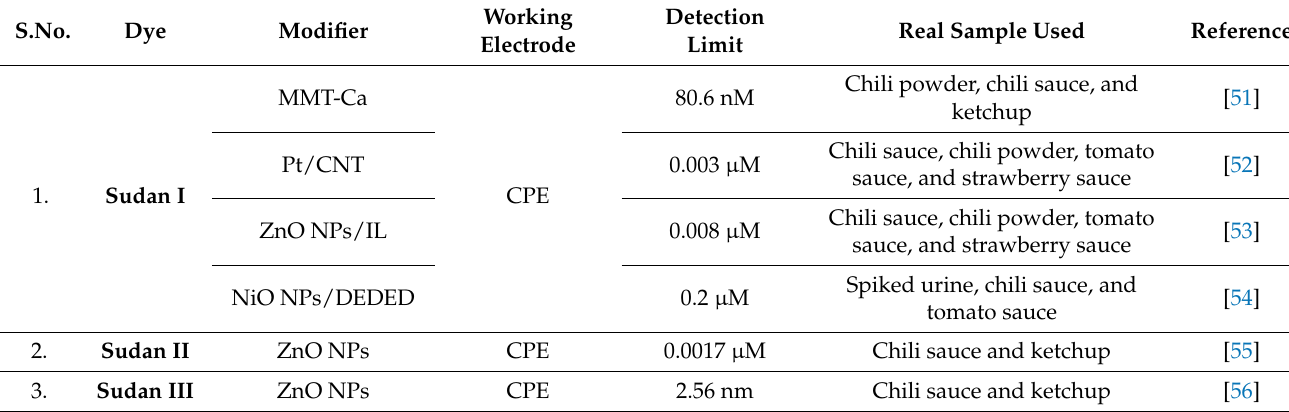
Table 10. Table showing Sudan detection using carbon paste electrodes with different modifiers along with their detection limits. S.No. Dye Modifier